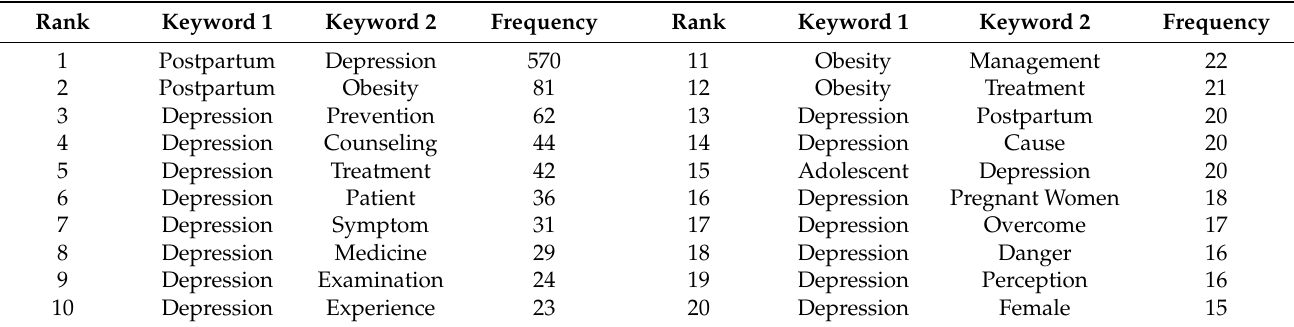
Table 2. Frequency of keywords using the N-gram